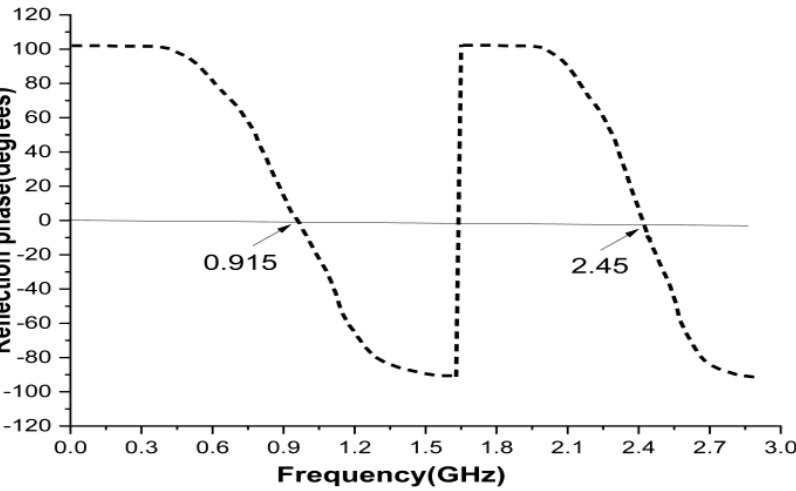
Figure 7. Reflection phase results of unit cell.